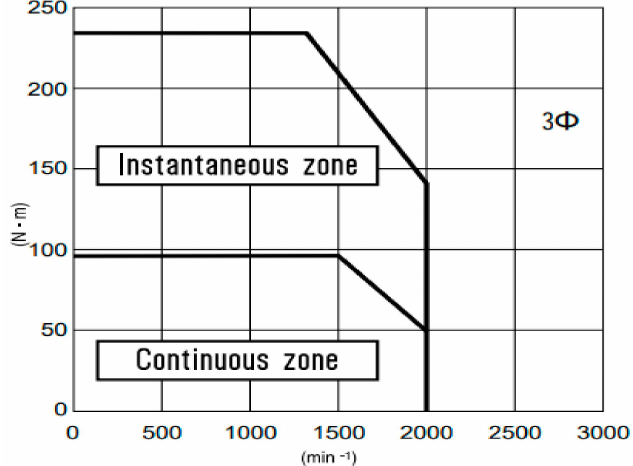
Figure 3. Torque–speed curve of the motor considered as an application example in this work. The symbol 3 Φ means that it is a three-phase powered